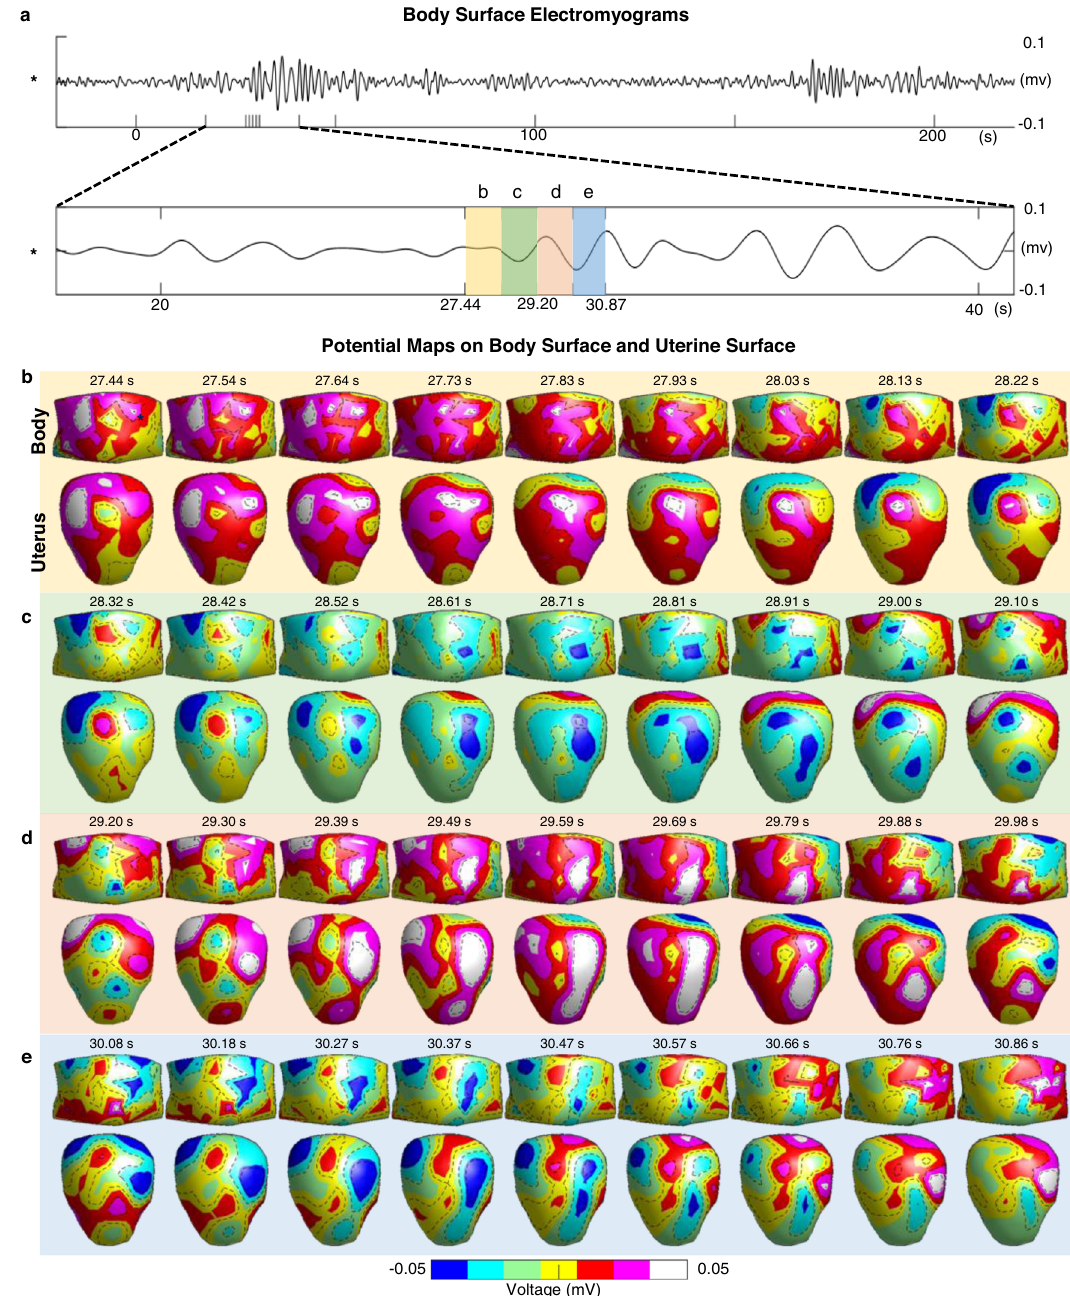
Fig. 2 | Quanti fi cation of contractions with 3D uterine surface potential maps. a A representative body surface EMG was measured at the location labeled as star (*)inSubject#2experiencingauterinecontractioninthelatentphaseoflabor.One segmentfrom~18thsecondto41stsecondwasmagni fi ed. b – e Sequentialpotential